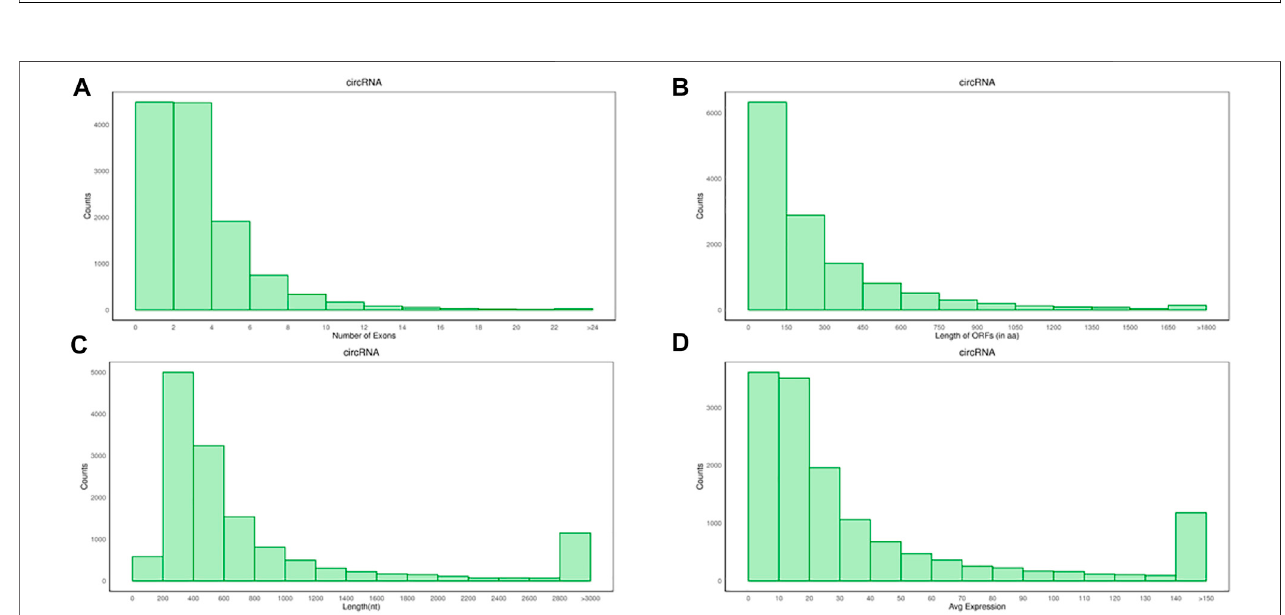
FIGURE 1 | Identi fi cation of circRNAs. (A) The number of identi fi ed circRNAs. Yellow represents H group, blue represents L group. The overlap represents the number of genes shared between the two groups, and non-overlap represents genes unique to each group. (B) The length of circRNAs. The abscissa represents the length of circRNAs, the ordinate represents frequency. (C) The location distribution of circRNAs. The abscissa represents the annotation type, the ordinate represents thenumberofcircRNAs. (D) Thechromosomedistributionofidenti fi edlncRNAs.Theabscissarepresentsthechromosome,theordinaterepresentsthenumberof circRNAs. Red represents H group, blue represents L group.